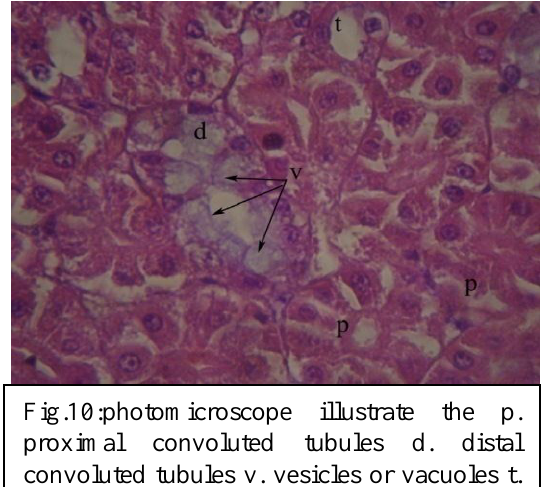
Fig.7:photomicroscope illustrate g. glomeruli which located in the pc. peripheral cortex , cv. Central vein and m. medulla. (HandE, X10)